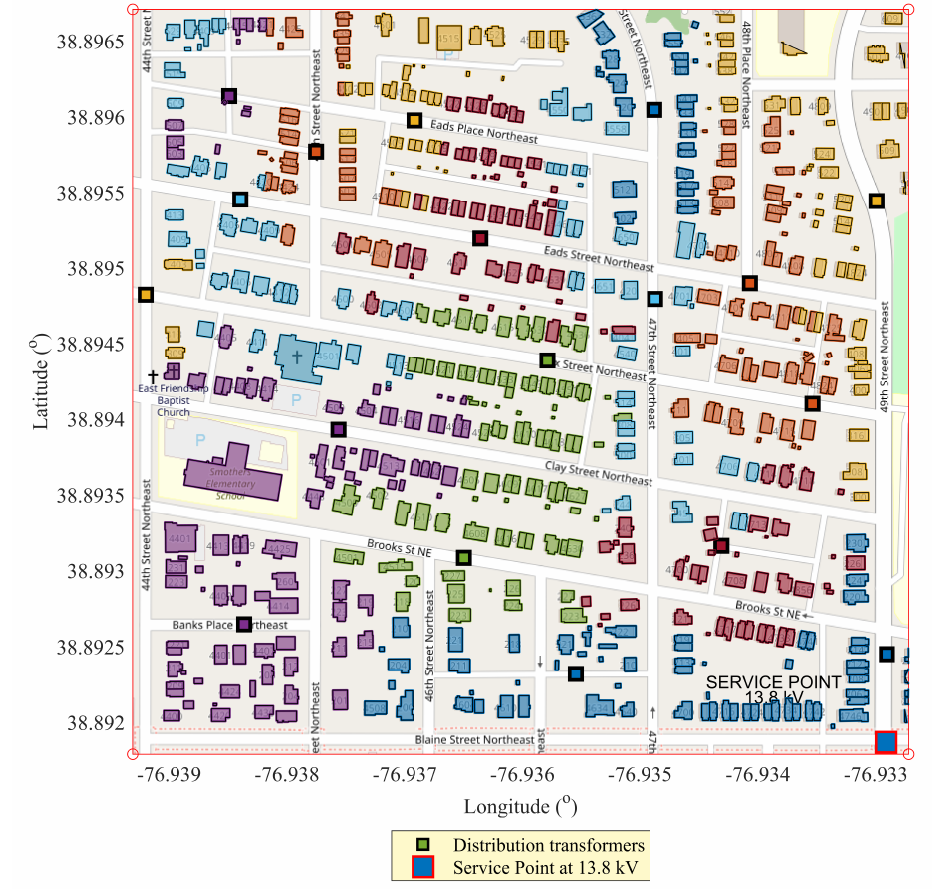
Figure 4. Case study 2: Low voltage distribution networks, where distribution transformers and end users are represented with different colors depending on the